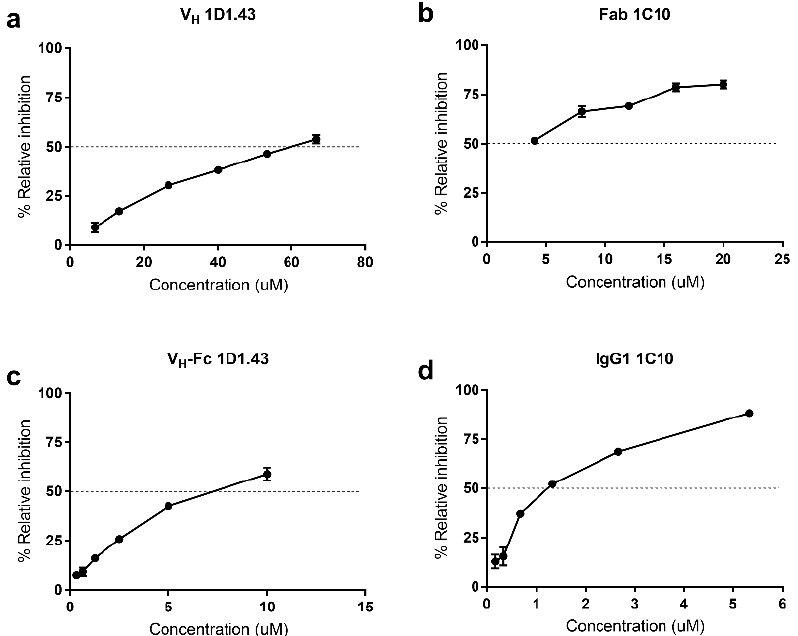
Figure 3. Inhibition effects of V H /V H -Fc 1D1.43 and Fab/IgG1 1C10 on enzyme activity. ( a , c ) Inhibition of V H 1D1.43 (a) and V H -Fc 1D1.43 ( c ) on NE enzyme activity. ( b , d ) Inhibition of Fab 1C10 ( b ) and IgG1 1C10 ( d ) on NE enzyme activity. Each experiment was performed in duplicate. Calculation: choose two time points (T1 and T2) in the linear range, determine the Fluorescence (FLU) at each time (FLU1 and FLU2) and use them to determine the Slope. Slope = (FLU2 − FLU1)/(T2 − T1) = ∆ FLU/minute. %Relative inhibition = (Slope EC − Slope SM )/Slope EC × 100%; Slope EC = the slope of the Sample inhibitor and Slope SM = the slope of the Enzyme control. Values were reported as the mean ± SD.